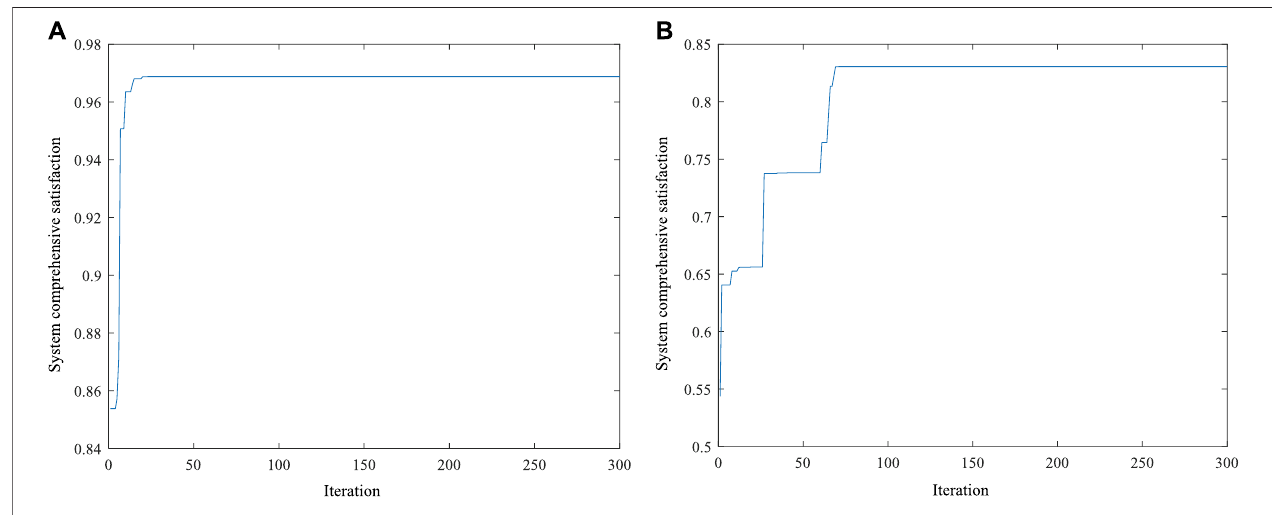
FIGURE 8 | Solving process of the comprehensive satisfaction objective for MEFCS. (A) Simpli fi ed primal dual interior point method. (B) Particle swarm optimization algorithm.